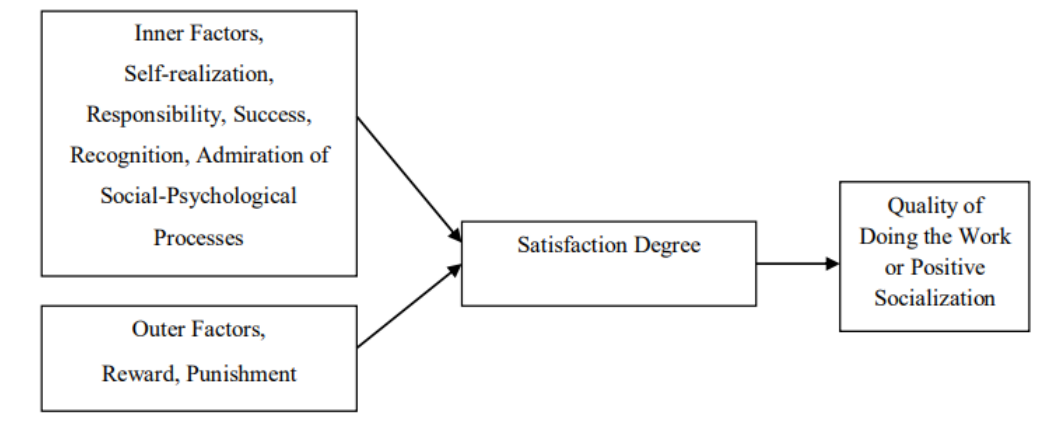
Figure 2. Model of Self-Realization